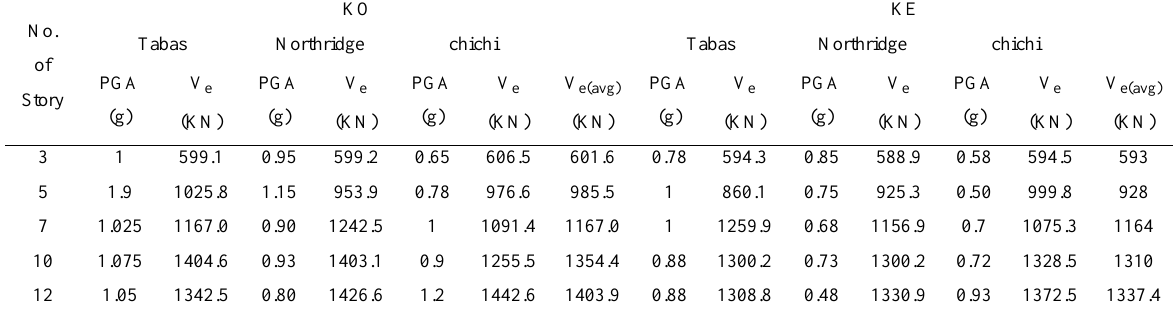
Table. 5. Nonlinear maximum base shear and PGA for KO and KE under Tabas, Northridge and Chichi ground motion.